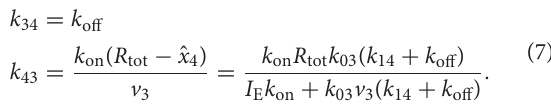
Frontiers in Immunology |